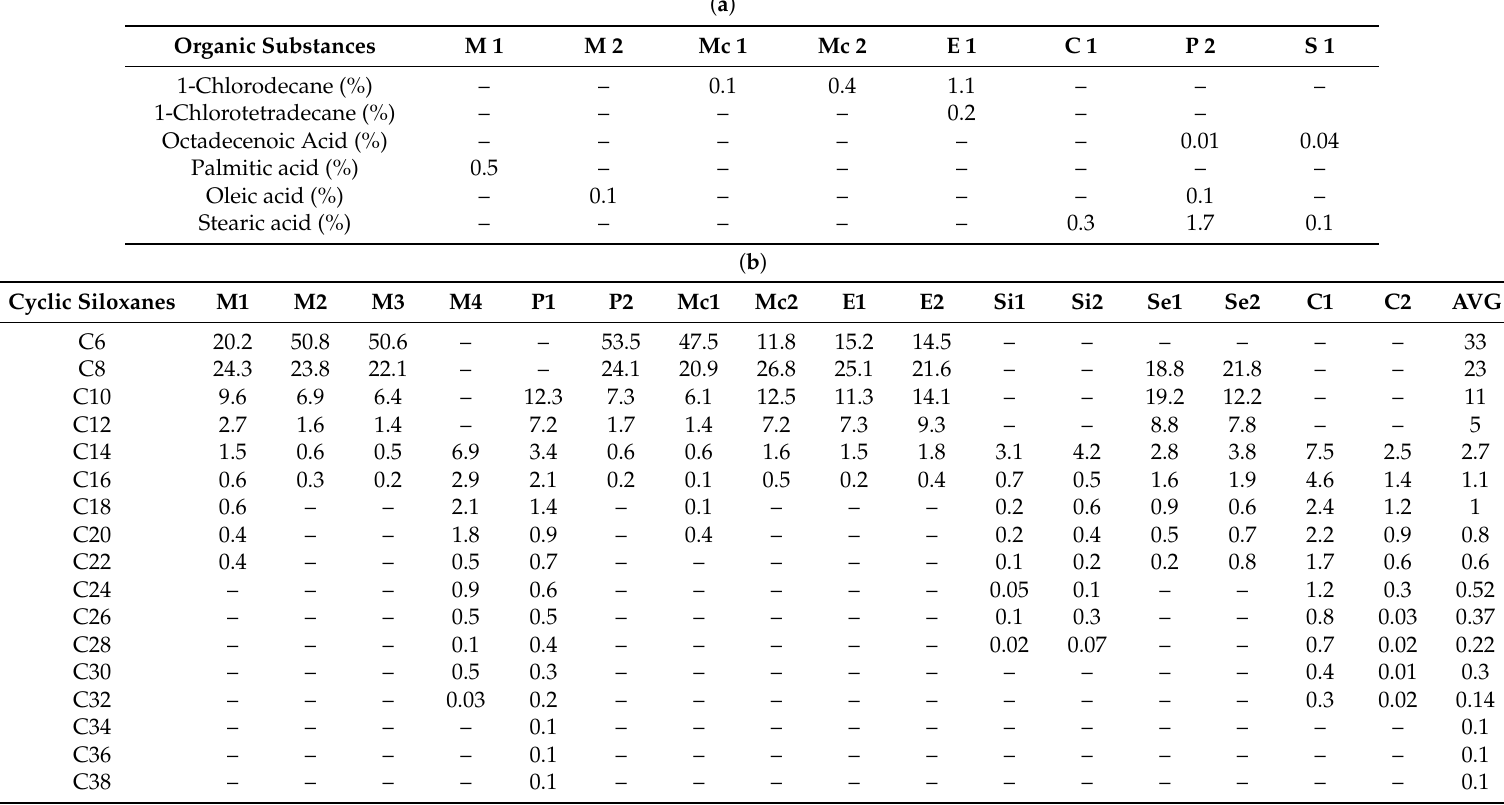
Table 2. ( a ) Organic substances (if present) revealed in gel implants; ( b ) Cyclic siloxanes content of gel implants (%); ( c ) Linear siloxanes content of gel implants